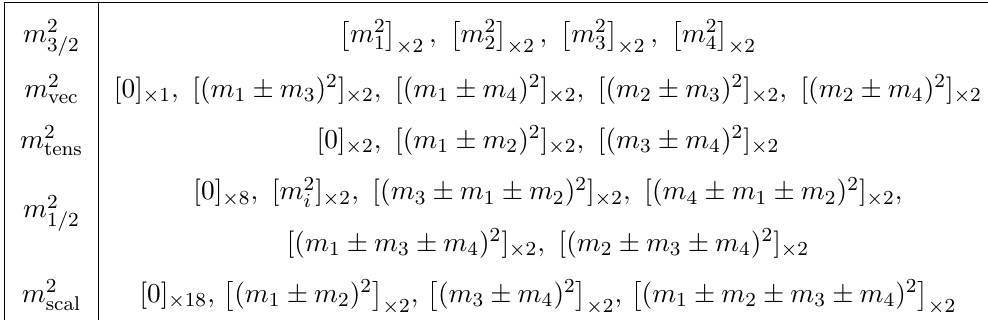
Table 15 . Masses for the CSS vacuum M1.